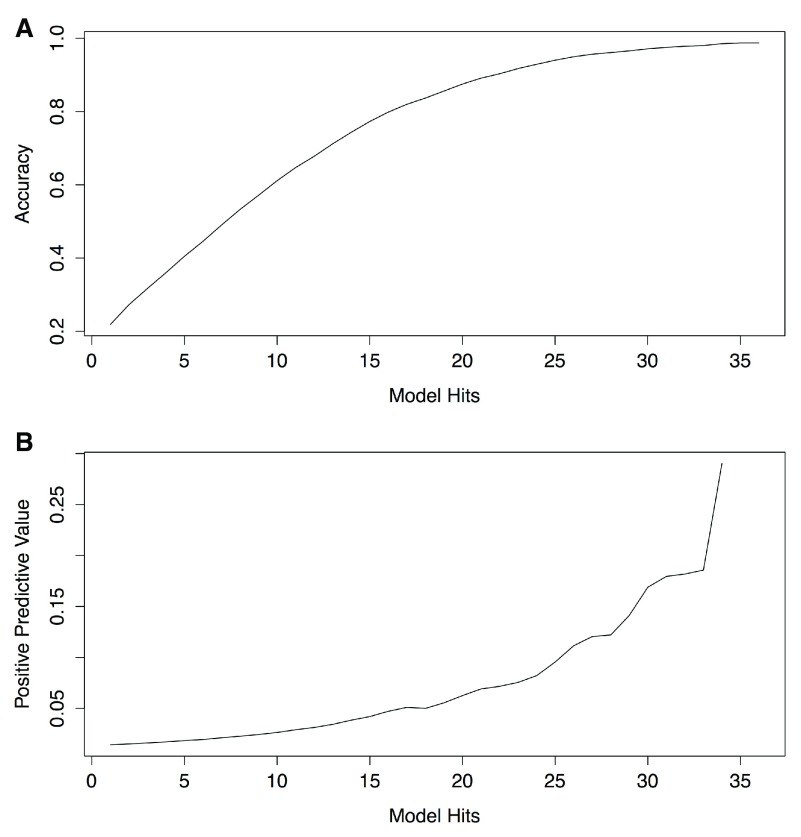
Simple voting method for combining models.
A. Accuracy of combined patterns for classification. Matches to PILGram-generated regular expression patterns for the MDR transporters were counted (X axis) and accuracy (Y axis) calculated based on the known positives and negative examples datasets (see text). Peak accuracy is attained when all 36 patterns match the sequence, indicating that the diversity of MDR transporter sequences is likely to be high. Redundancy analysis (
Table 3) shows that a similar accuracy can be obtained with seven patterns.
B. Positive-predictive value of combined patterns for classification. Positive predictive value (the percentage of true positives in all positive predictions; Y axis) was calculated for each number of MDR transporter pattern matches (X axis). The maximum value is reached in sequences that match all patterns.